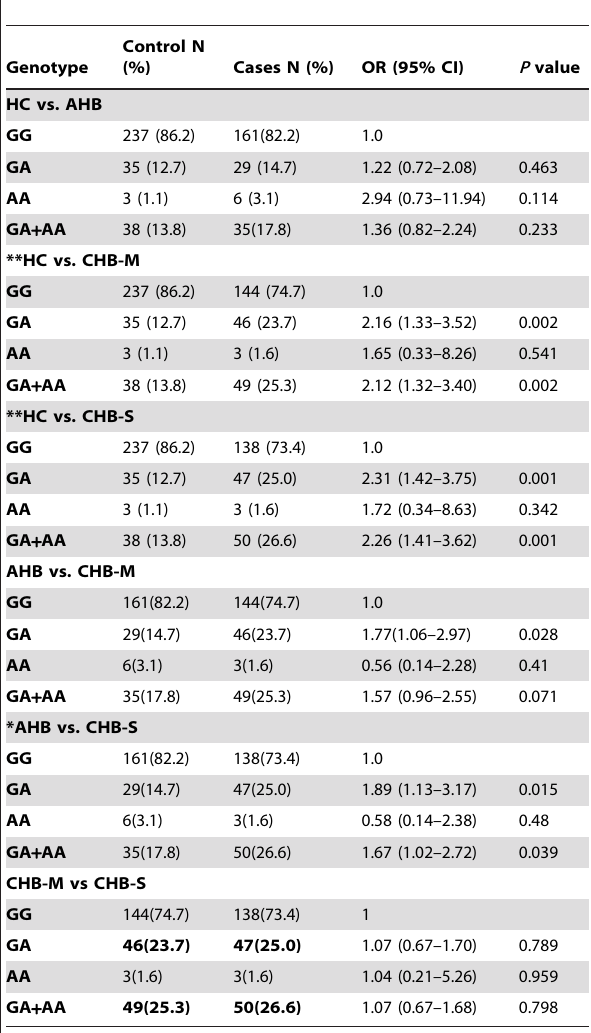
Table 3. G-201A frequencies and odds ratio for the association with disease